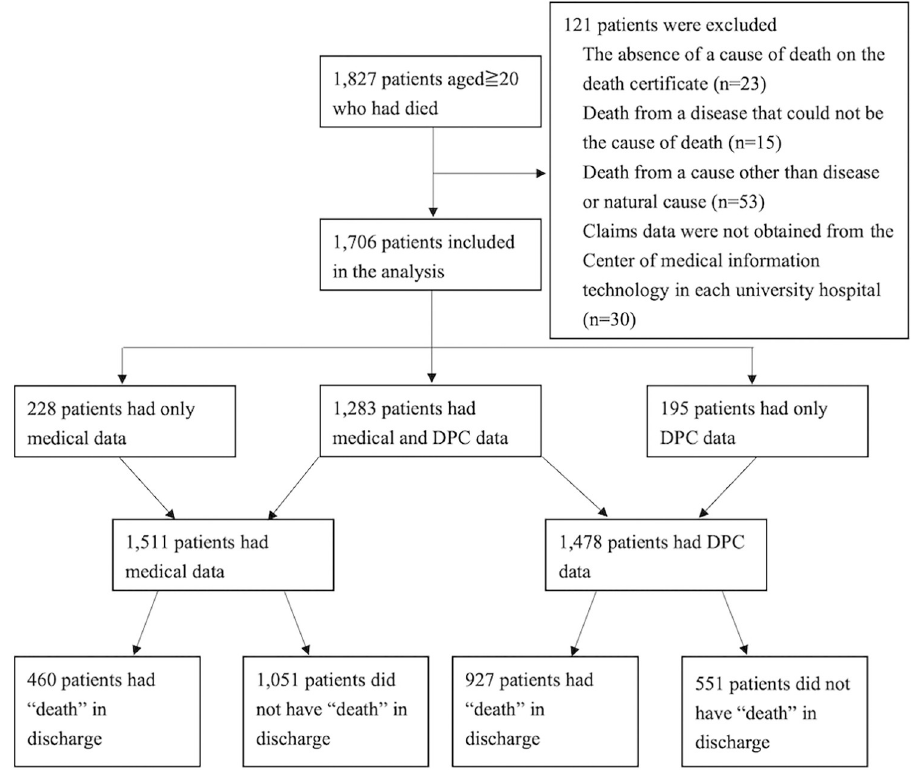
Fig 1. Eligibility flow. Abbreviations; DPC, Diagnosis Procedure